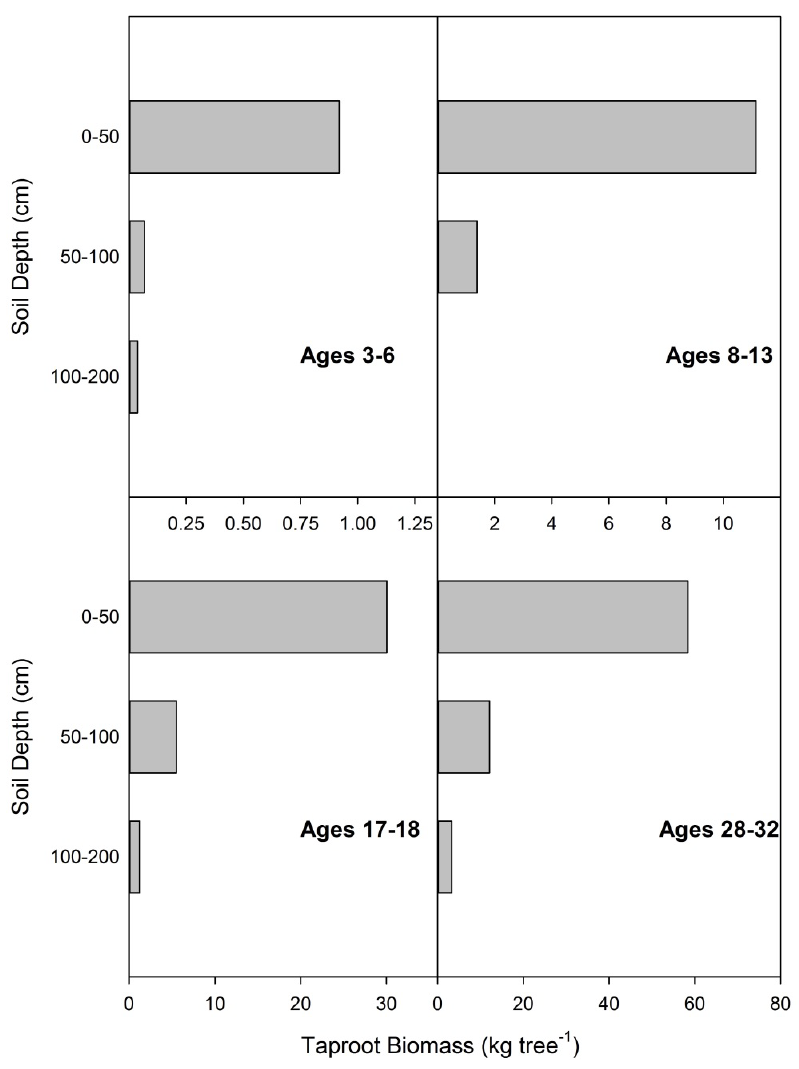
Figure 5. Taproot biomass distribution at four ages. Data are from 11 destructively sampled loblolly pines on reclaimed mineland in east